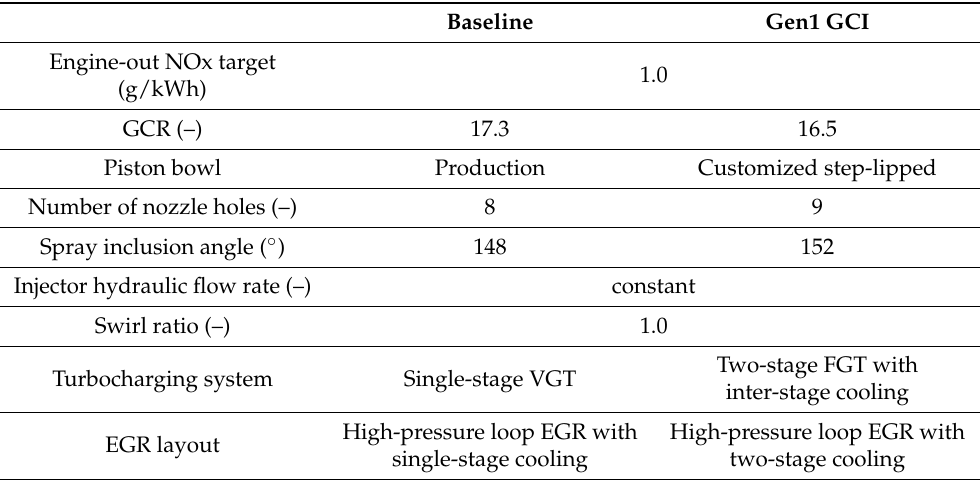
Table 3. Key specifications for the baseline engine and the Gen1 GCI